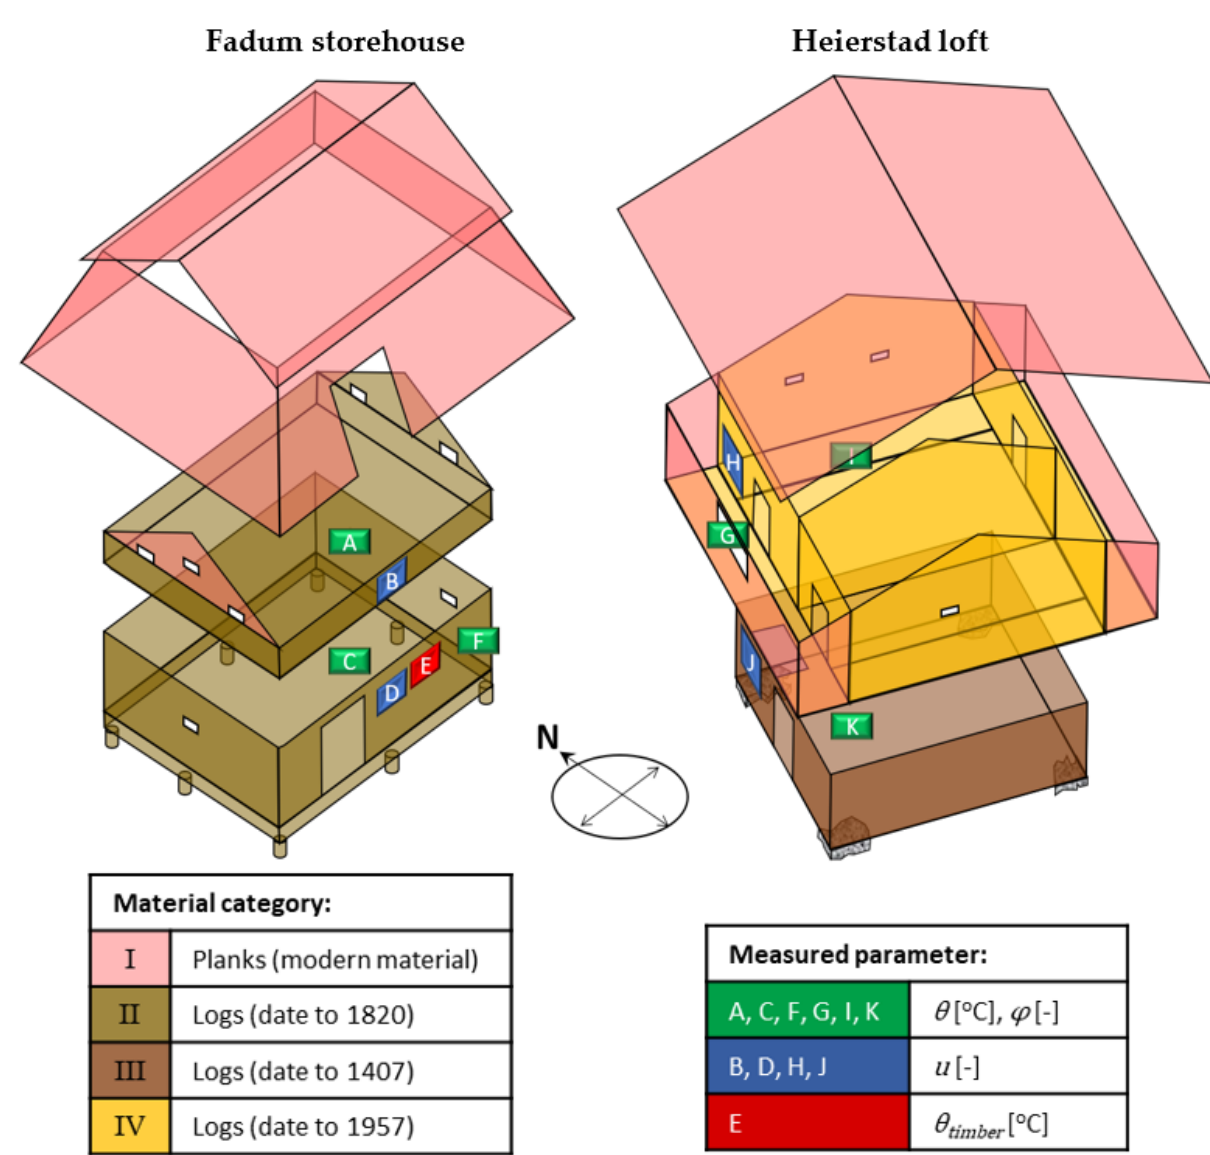
Figure 2. The building components have been grouped in four homogeneous categories, highlighted with different colors, based on the type and age of wood that they are made of. The positions of the installed sensors are also highlighted with green color for the air temperature and humidity sensors (A, C, F, G, I, K), blue color for the moisture content sensors (B, D, H, J), and red color for the sensor monitoring the temperature inside the timber (E).